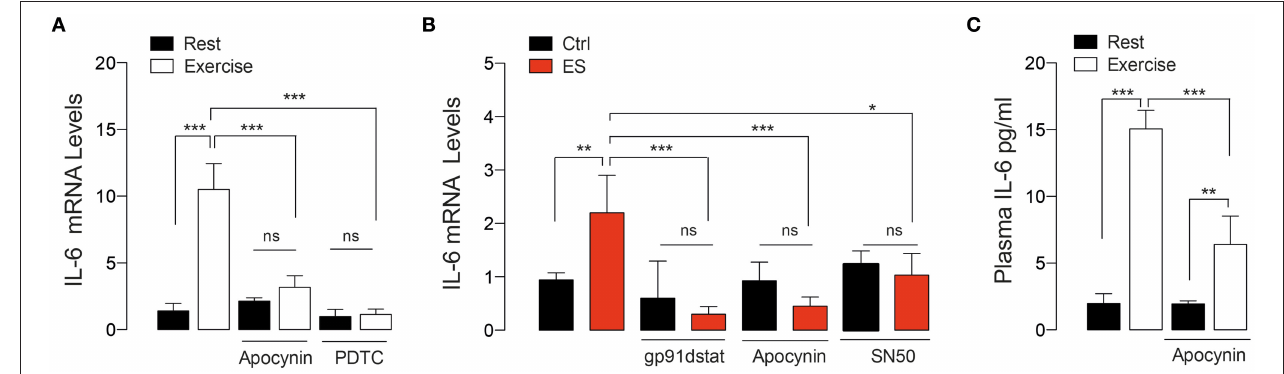
FIGURE 3 | NOX2-dependent ROS production is involved in IL-6 gene expression induced by both in vivo and in vitro exercise. (A) Levels of muscle IL-6 mRNA after exercise in mice treated with vehicle, apocynin and PDTC (NF- κ B inhibitor). (B) Levels of IL-6 mRNA in isolated skeletal muscle fibers that were pre-incubated with either apocynin or gp91-dstat (NOX2 blockers) or SN50 (NF- κ B inhibitor) before electrical stimulation (ES). (C) Plasma IL-6 levels obtained immediately after exercise in both apocynin- or saline-treated mice. Data are expressed as mean ± SD from five different determinations. * p < 0.05 , ** p < 0.01 , *** p < 0.001 ; ns, no significant difference, one-way ANOVA-